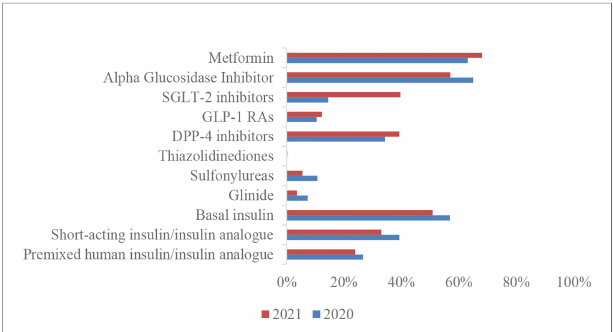
FIGURE 1 | Application rates of different categories of hypoglycemic agents of inpatients with type 2